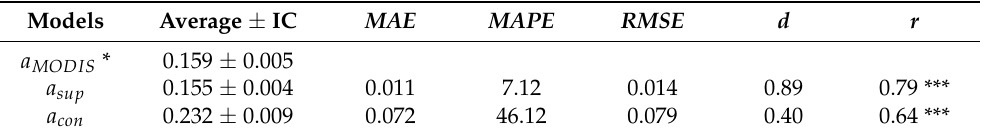
Table 3. Average ( ± 95% confidence interval) of the surface albedo estimated by MODIS ( a MODIS ) used as reference values, and the average ( ± 95% confidence interval), mean absolute error ( MAE ), mean absolute percent error ( MAPE , %), root mean square error ( RMSE ), Willmott coefficient (d), and Pearson correlation coefficient (r) of the surface albedo estimated by the model developed in this study ( a sup ) and the surface albedo estimated by the conventional model ( a con ). Values with (***) indicate p -value < 0.001. All units are dimensionless.